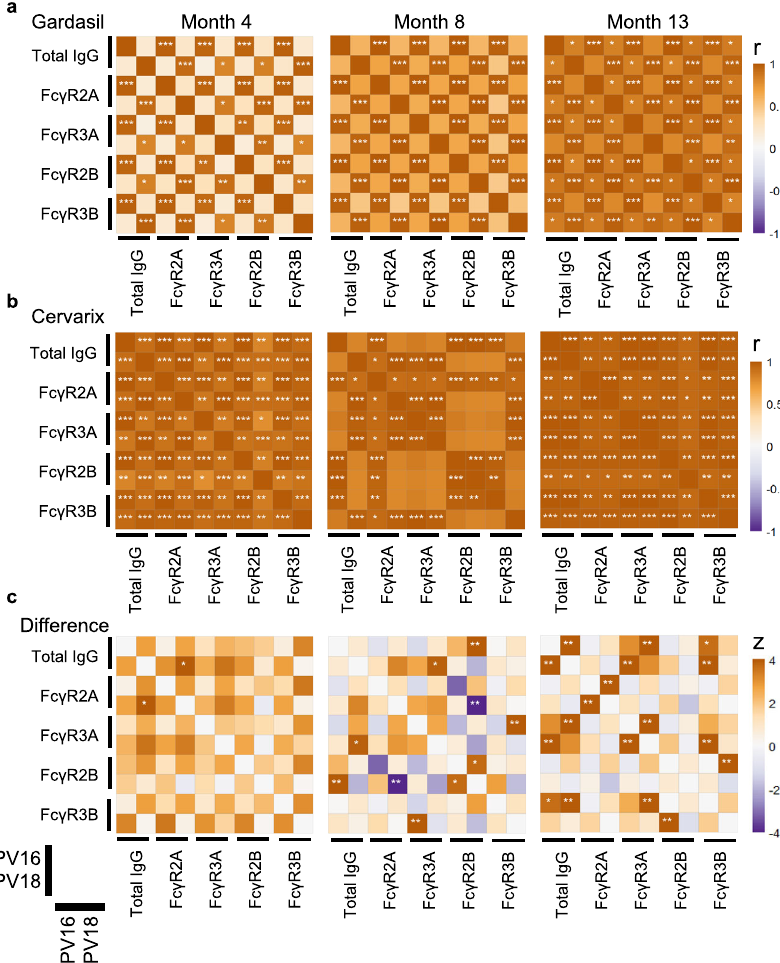
Fig. 4 Differences across the two vaccine groups in correlation between immune responses to HPV genotypes. a , b Heatmaps showing Spearman correlation ( r ) between total IgG and Fc-receptor bindings in Gardasil ® ( a ) and Cervarix ® ( b ) recipients. Cervarix ® group shows a more coordinated response across HPV 16 and 18. c Differential correlations ( z ) calculated using Fisher ’ s r -to- z transformation. Orange represents higher r for Cervarix ® group, while purple represents higher r for Gardasil ® group. *, **, and *** indicates 0.01 ≤ p < 0.05, 0.001 ≤ p < 0.01, and p < 0.001, respectively. p -values are multiple test-corrected by the Benjamini-Hochberg procedure for all comparisons between features from each